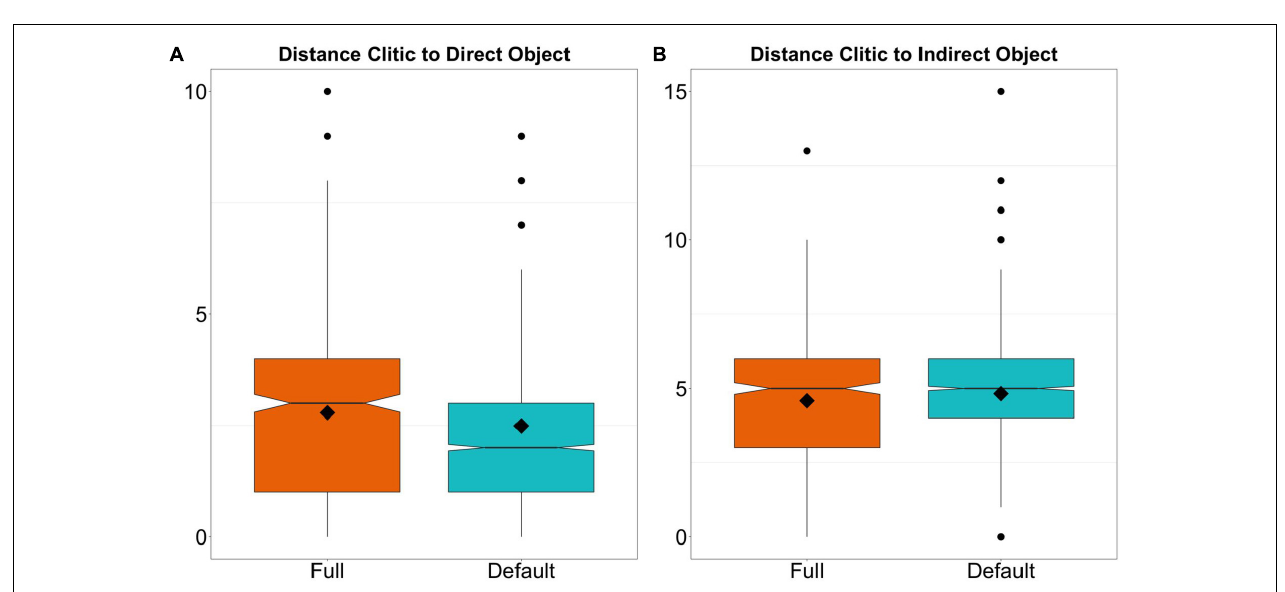
FIGURE 2 | Distribution of full and default agreement by country. The x-axis represents the relative frequency of each clitic in each country.